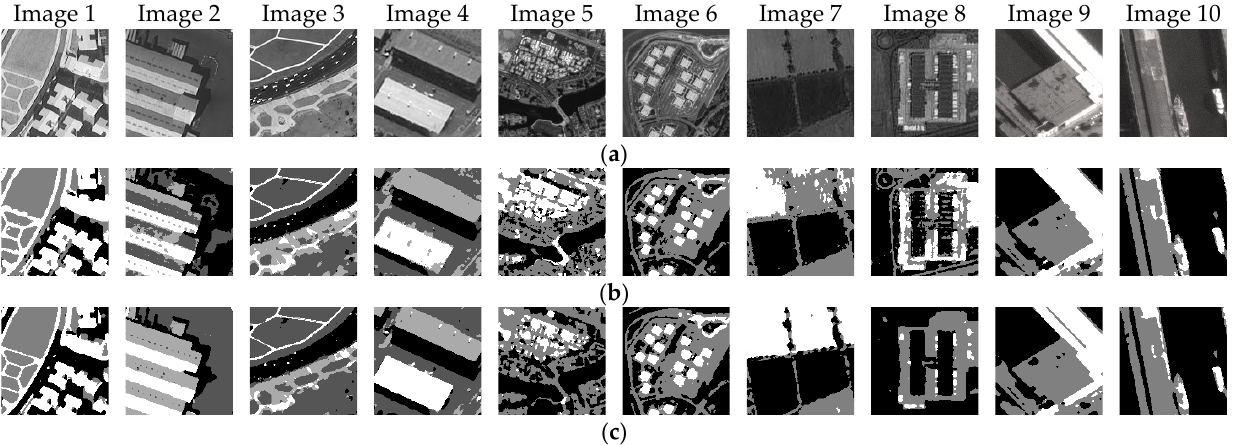
Figure 10. High-resolution remote sensing images and their segmentation results. ( a ) high-resolu- tion remote sensing images, ( b ) HGMM-GD algorithm, ( c ) HSMM